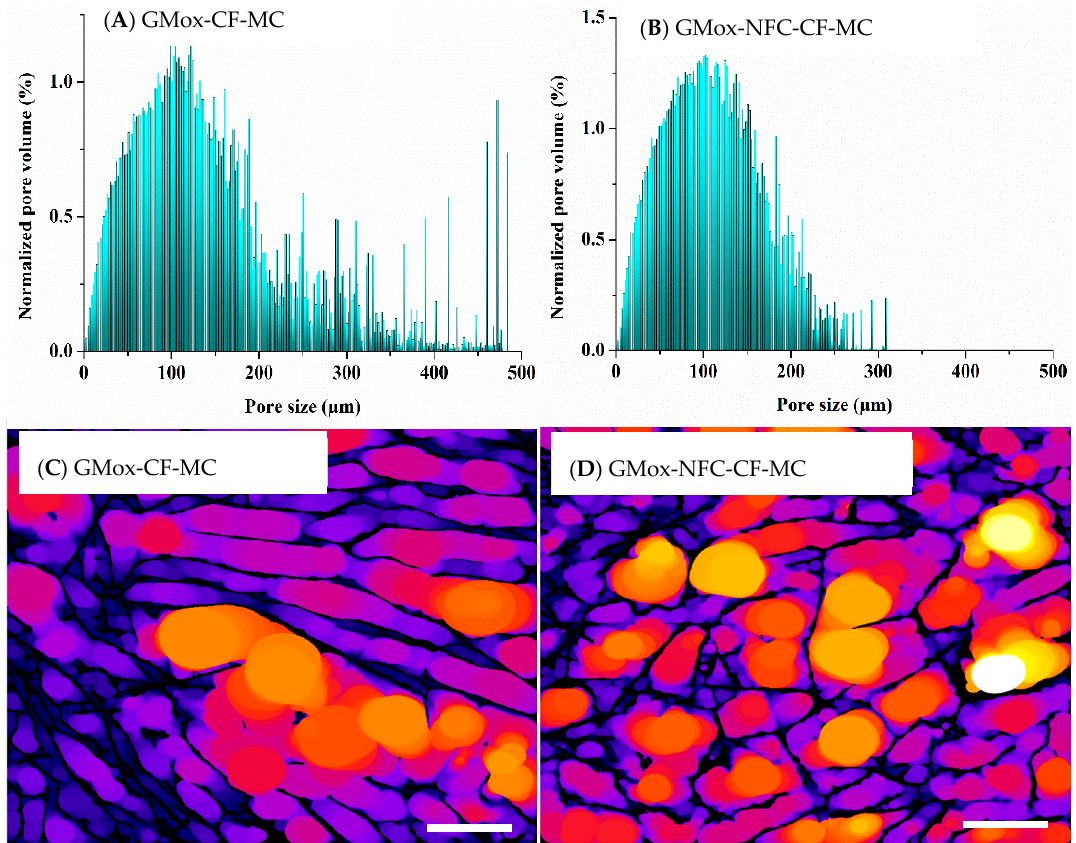
Figure 9. Volume-weighted pore-size distribution of ( A ) GMox and ( B ) GMox-NFC. Segmented middle slice (s1080/2160) from the local thickness map of ( C ) GMox and ( D ) GMox-NFC for pore-size distribution. Aerogels were prepared by the conventional freezing (CF) method. MC = mechanically compressed. The scale bar in C and D is 100 μ m.